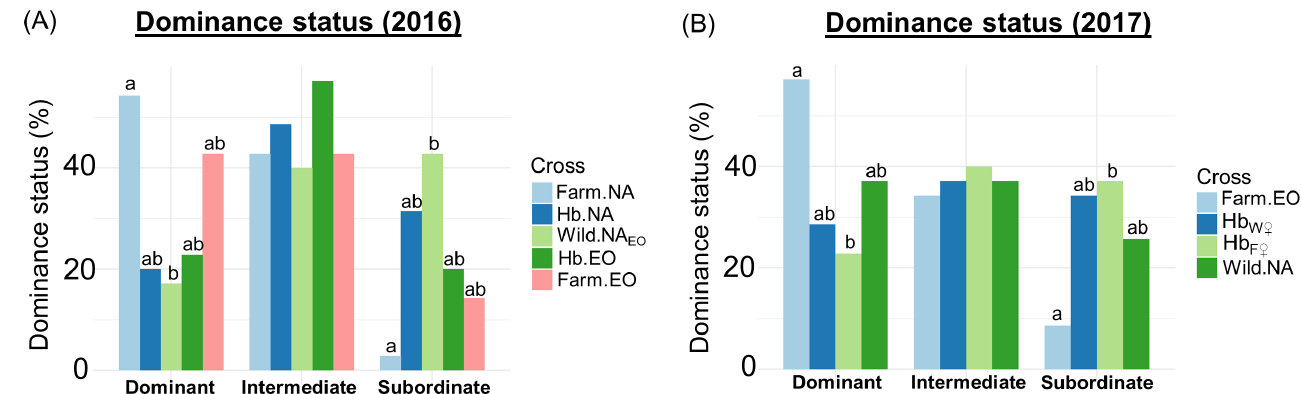
Fig. 2. Dominance status (%) among different cross types in the (A) 2016 and (B) 2017 dominance experiments with Atlantic salmon. Different letters indicate significant differences in dominance status among cross types. See Table S1 for Tukey- adjusted pairwise contrasts of different cross types for the estimation of dominance status. Cross types in 2016: Farm.NA: North American (NA) farmed; Hb.NA: hybrid Wild.NAEO × Farm.NA; Wild.NAEO: Newfoundland (NF) wild with a signal of European (EO) ancestry; Hb.EO: Wild.NAEO × Farm.EO; Farm.EO: EO farmed. Cross types in 2017: Farm.EO: EO farmed; Hb W f : Wild.NA f × Farm.EO m ; Hb F f : Wild.NA m × Farm.EO; Wild.NA: NF wild with no signal of EO